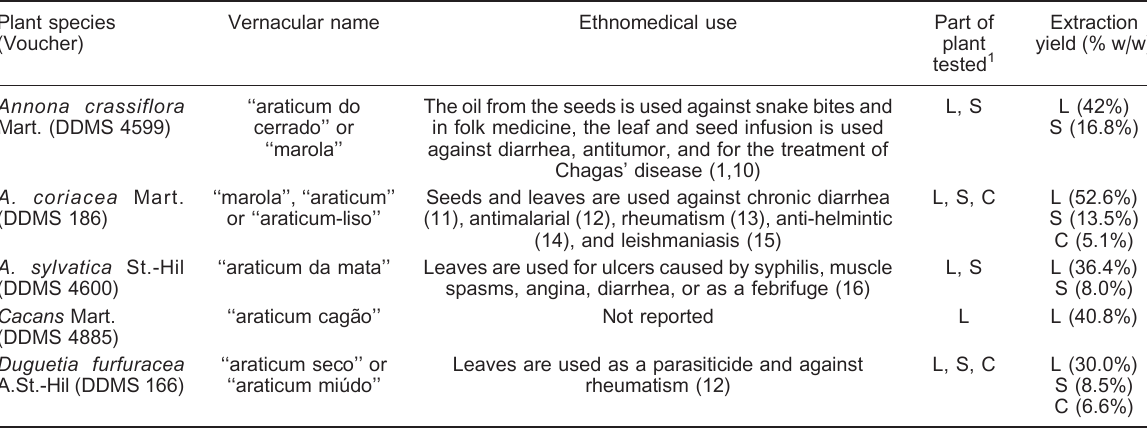
Table 1. Selected plant species from Annonaceae evaluated for antiproliferative and acetylcholinesterase inhibitory activities. Plant species